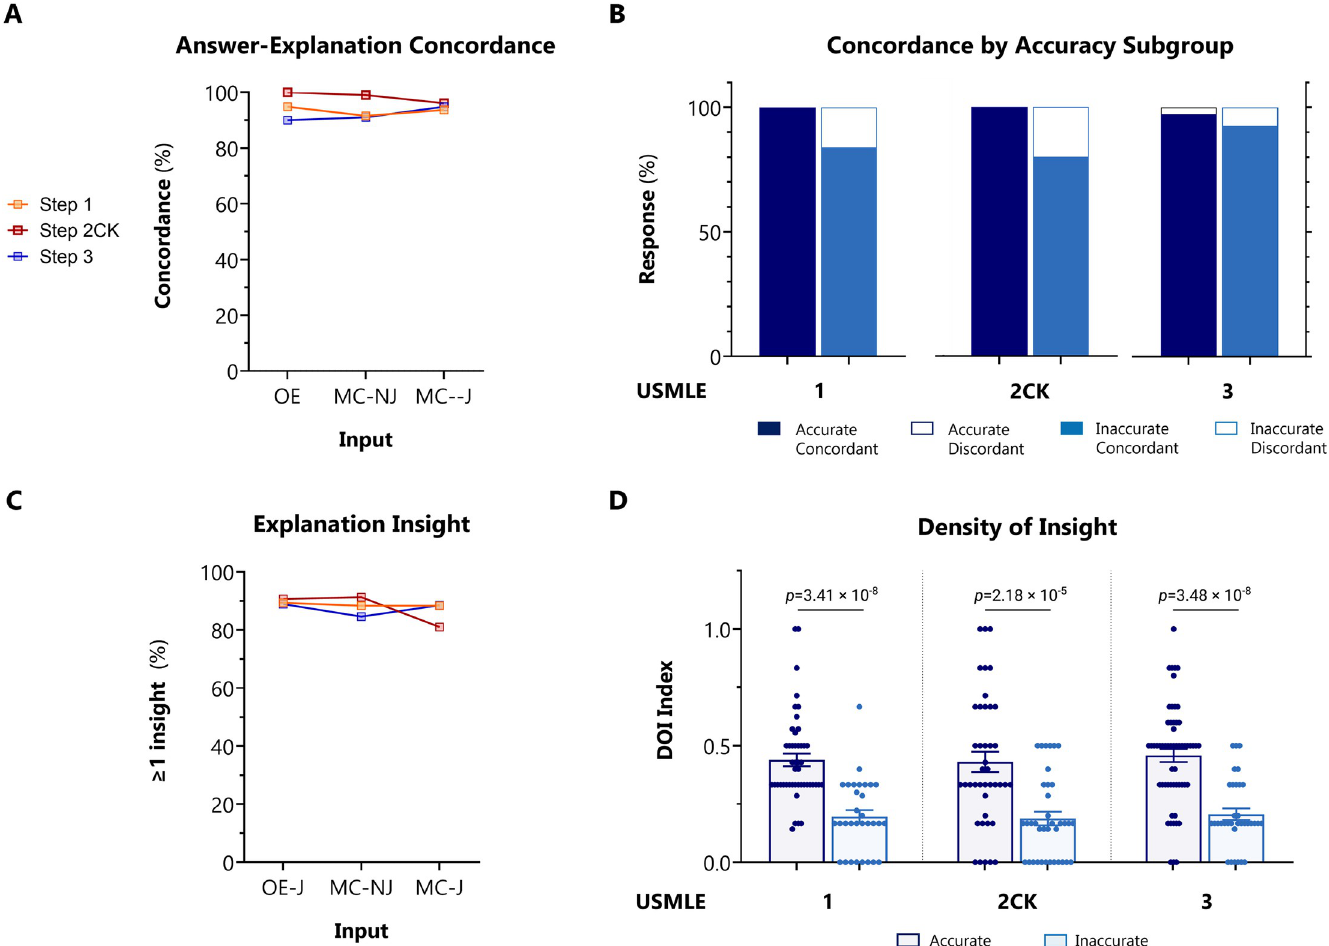
Fig 3. Concordance and insight of ChatGPT on USMLE. For USMLE Steps 1, 2CK, and 3, AI outputs were adjudicated on concordance and density of insight (DOI) based on the ACI scoring system provided in S2 Data . A: Overall concordance across all exam types and question encoding formats. B: Concordance rates stratified between accurate vs inaccurate outputs, across all exam types and question encoding formats. p < 0.001 for accurate vs inaccurate outputs by Fisher exact test . C: Overall insight prevalence, defined as proportion of outputs with � 1 insight, across all exams for questions encoded in MC-J format. D: DOI stratified between accurate vs inaccurate outputs, across all exam types for questions encoded in MC-J format. Horizontal line indicates the mean. p -value determined by parametric 2-way ANOVA testing with Benjamini-Krieger-Yekutieli (BKY) post hoc to control for false discovery rate.